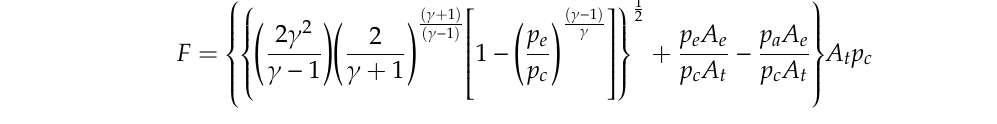
where F is the thrust produced by one thruster.